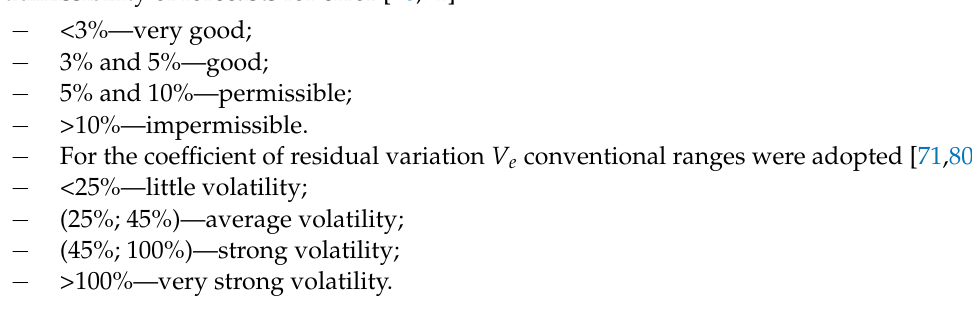
Table 3. Ex post forecast errors and mathematical dependence [68–73,75–79]. No Ex-Post Forecast Errors (Symbol) Mathematical